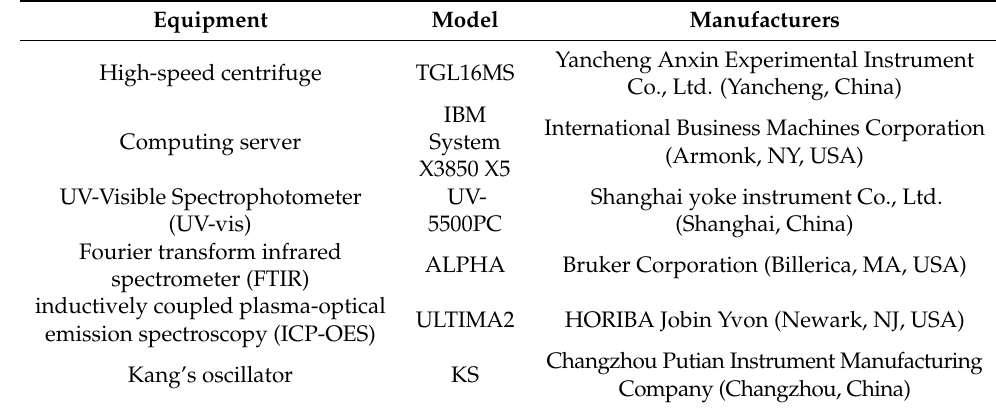
Table 2. Information of